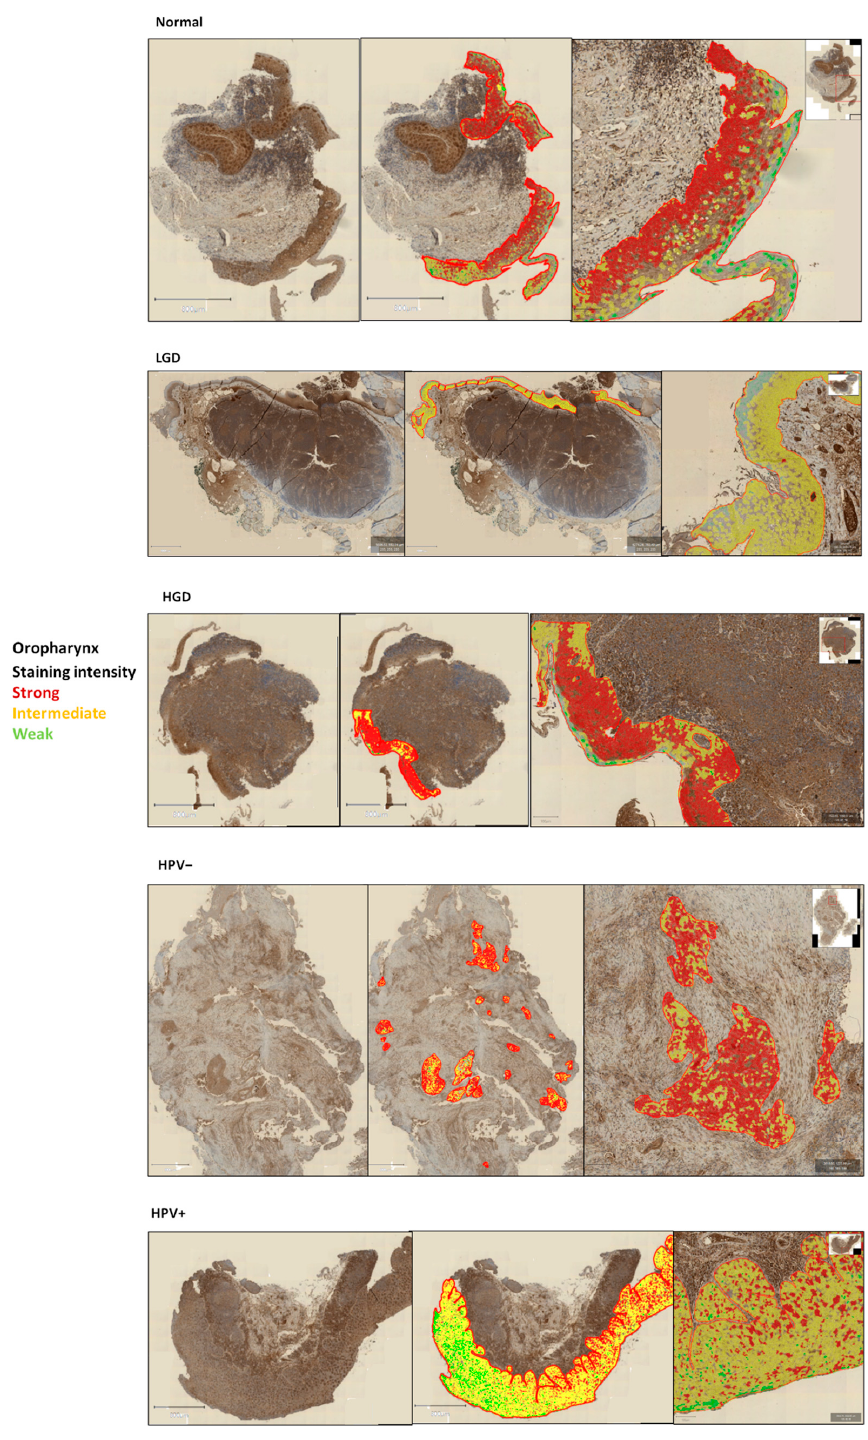
Figure 3. Representative sections from whole-slide scans (X20) of normal, low-grade dysplasia (LGD), high-grade dysplasia (HGD), and HPV − and HPV+ squamous cells from the oropharynx. The left panel shows the immunohistochemical staining for sCTLA-4 (DAB, brown) counterstained with haematoxylin (blue), scale bar represents 800 µ m. The middle panel shows the annotations and cell detections with colour-coded staining intensities for the same sections. The right panel represents zoomed-in views of the cell detection, with the scale bar representing 100 µ m and the inset showing the exact site of the magnified